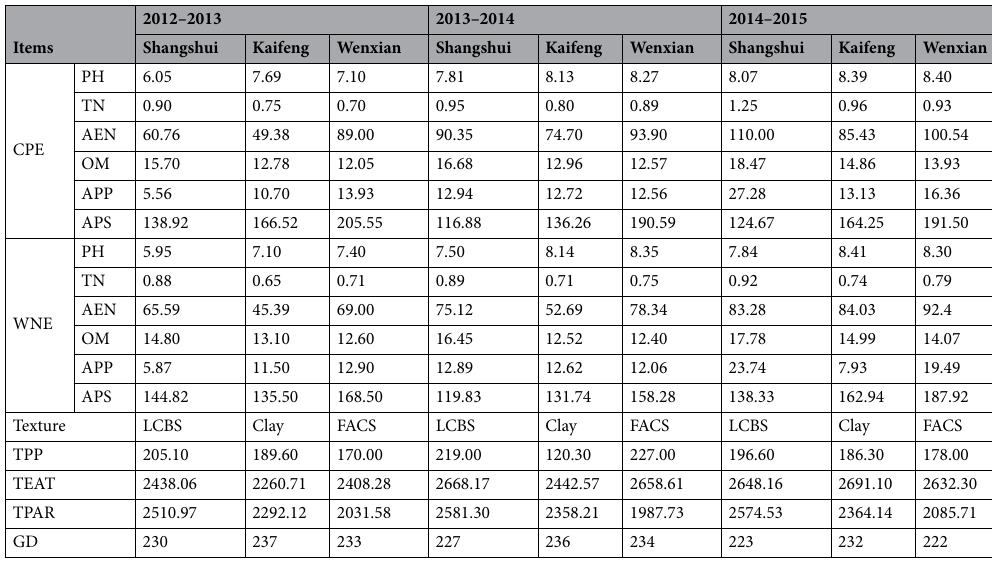
Table 3. Basic physicochemical properties of the study plots at a soil depth of 0–40 cm and meteorological data during the winter wheat growing period. Notes: CPE: Cultivation patterns experiments; WNE: Water-nitrogen mode experiments; TN: Total N (g kg − 1 ); AEN: Alkaline extractable N; OM: Organic matter (g kg − 1 ); APP: Available phosphorus (mg kg − 1 ); APS: Available potassium (mg kg − 1 ); LCBS: lime concretion black soil; FACS: fluvo-aquic clay soil; TPP: Total precipitation (mm); TEAT: Total effective accumulated temperature when averaged daily temperature > 0 °C during growth period (°C); TPAR: Total photosynthetic active radiation (MJ m − 2 ); GD: Growth days.